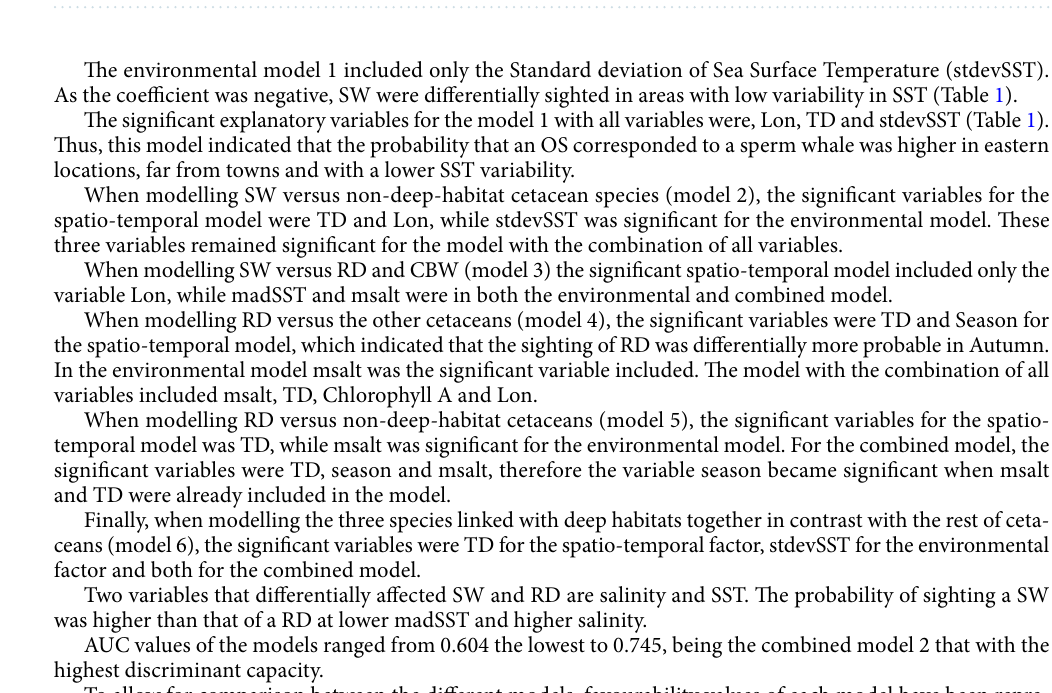
Figure 1. Distribution of the opportunistic sightings (OS) of deep-habitat cetaceans in the dataset. Bathymetry and location of cities with more than 100,000 inhabitants are also displayed. Maps were generated using ArcGIS 10.6 (source: Esri, DigitalGlobe, GeoEye, Earthstar. Geographics, CNES/Airbus, DS, USDO, USGS, AeroGRID, IGN, and the GIS User Community: www. esri.